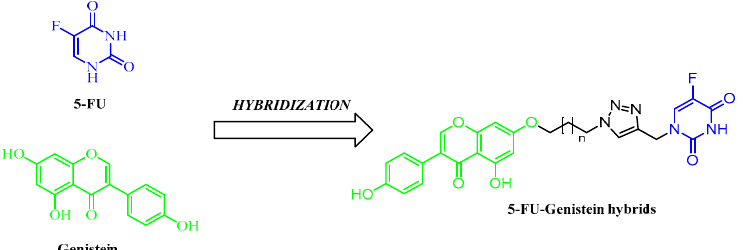
Figure 2. Design of 5-FU-Genistein hybrids.